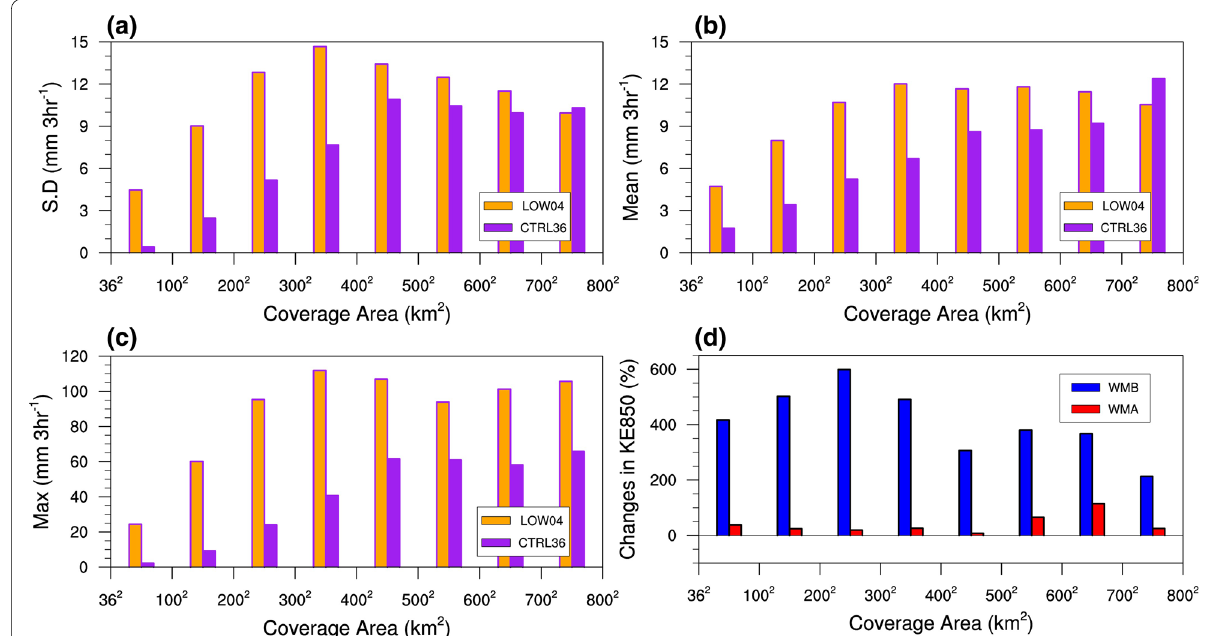
Fig. 7 Variation in precipitation intensities based on the size of the rain cell: a – c standard deviation, average, and maximum precipitation